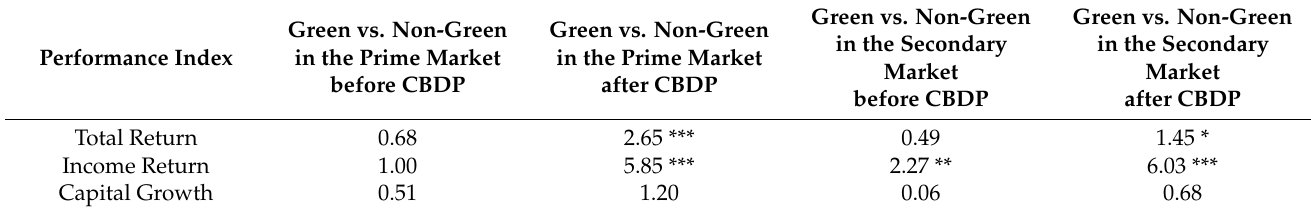
Table 8. Prime and secondary markets: parametric t -value of non-green (0–3.5 stars) vs. green (4–6 stars).